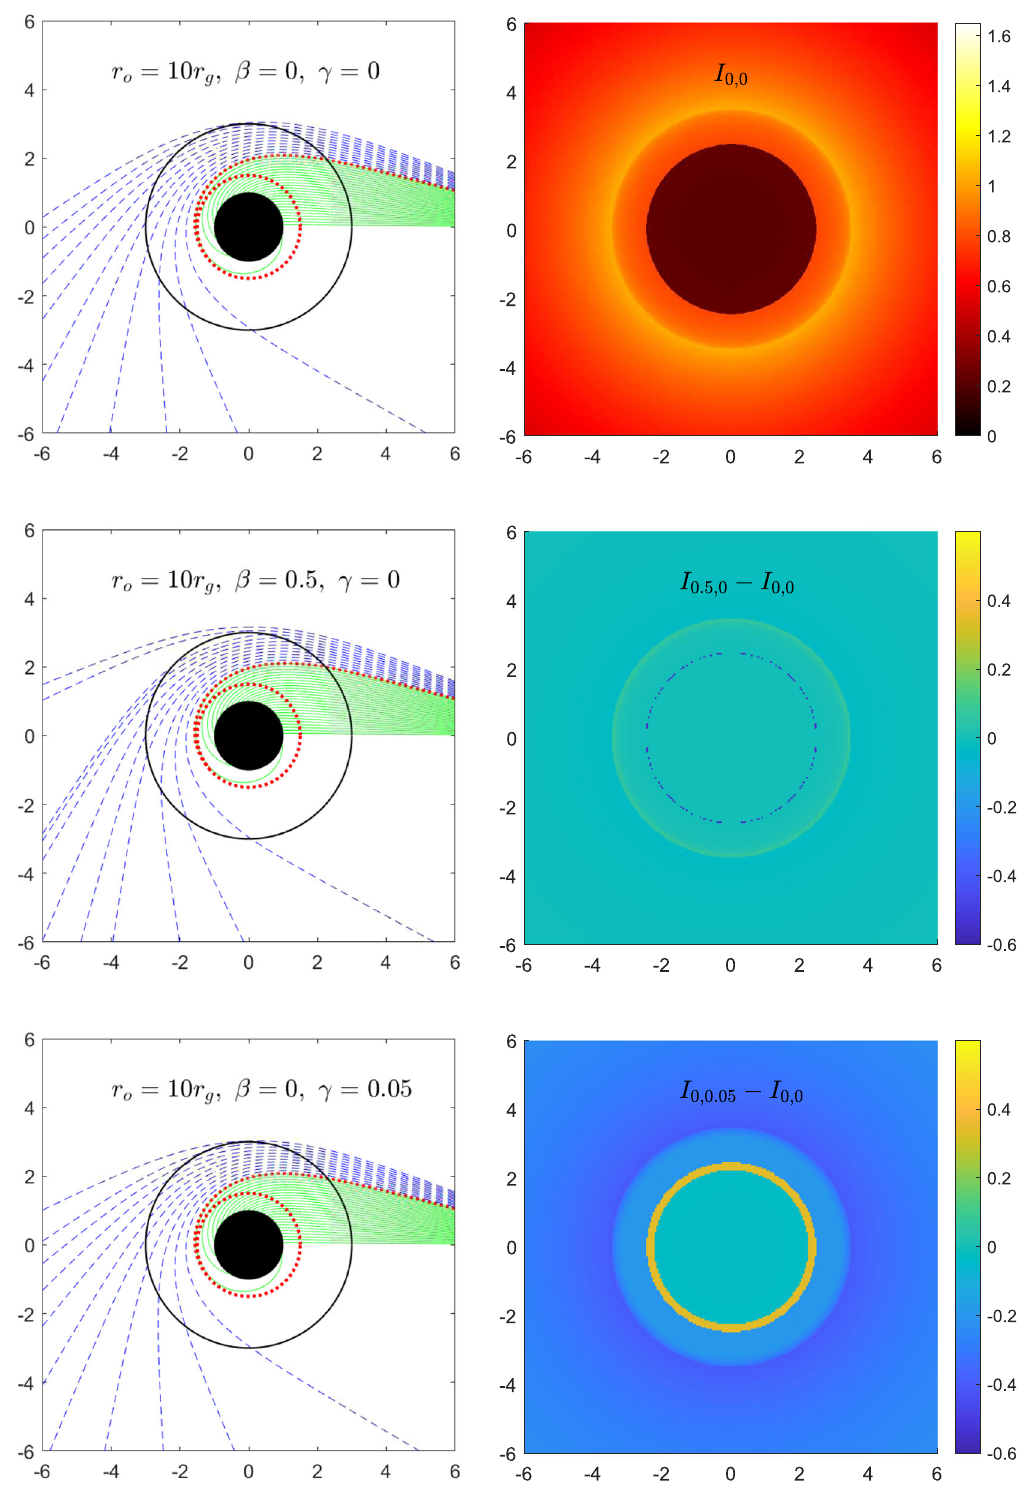
Fig. 4 Influences of the plasma on the intensity of the black hole shadow for model B in Sect. 5. Left panels: trajectories of the light rays observed at the point ( x , y ) = ( 10 r g , 0 ) . Green solid curves, red dotted curves and blue dashed curves depict trajectories with b < h ( r ph ) , b = h ( r ph ) and b > h ( r ph ) respectively. The interval of adjacent